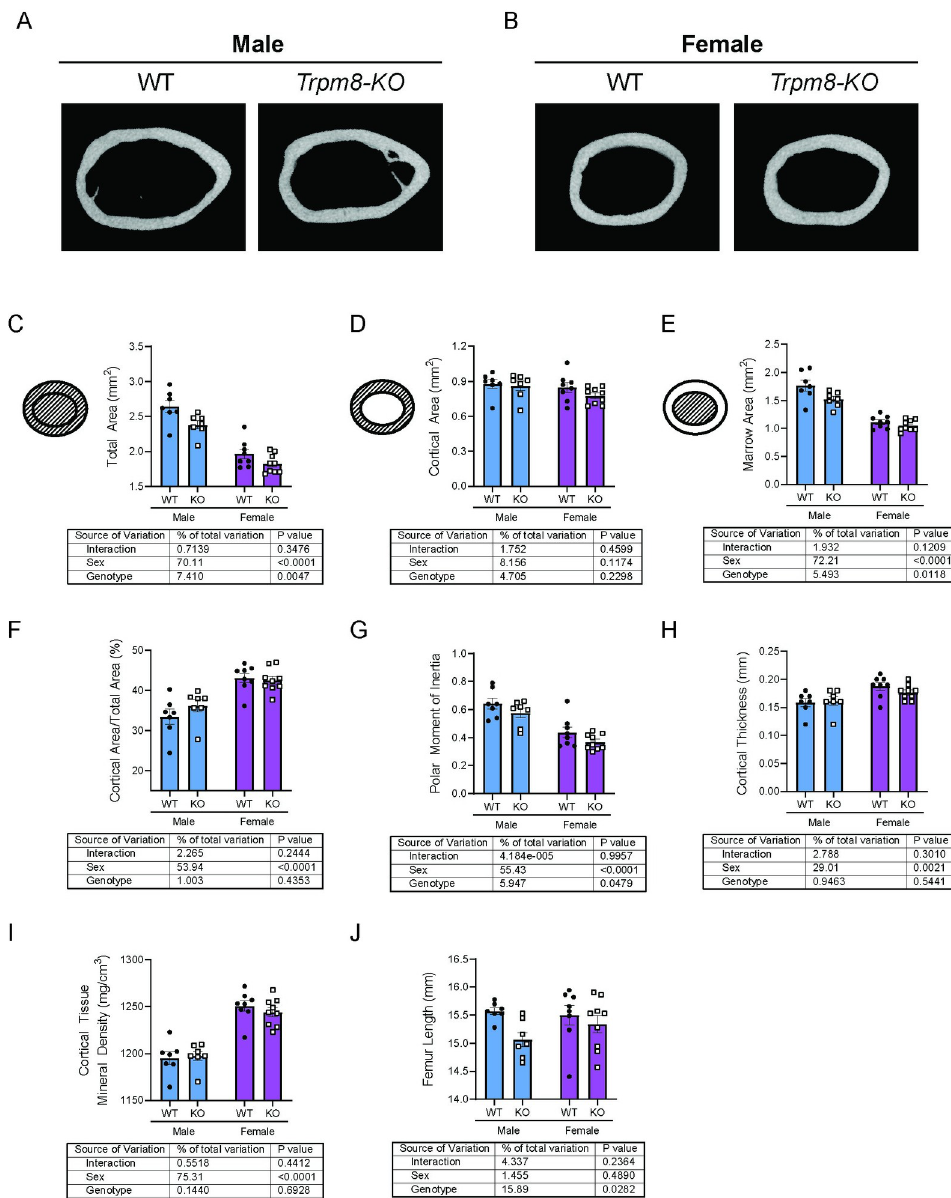
Fig 2. Trpm8 deletion reduced femur size in male mice. Femurs from room temperature housed male and female Trpm8-KO and WT mice were scanned by μ CT. (A, B) Representative images of the femur cross section from the midshaft, where cortical microarchitectural measurements were performed (C-J). Cortical bone images were taken of the mouse using the median total area value within each group. Shaded areas of the pictograms in C, D represent the region of interest for each measurement. N = 7–9 per group. Data are expressed as individual points with bars representing mean ± SEM. Tables below each panel indicate results of the two-way ANOVA, with p- values for sex, genotype and their interaction. p -values above the bars represent results from Holm-Sidak post hoc test for pairwise significance after a significant interaction